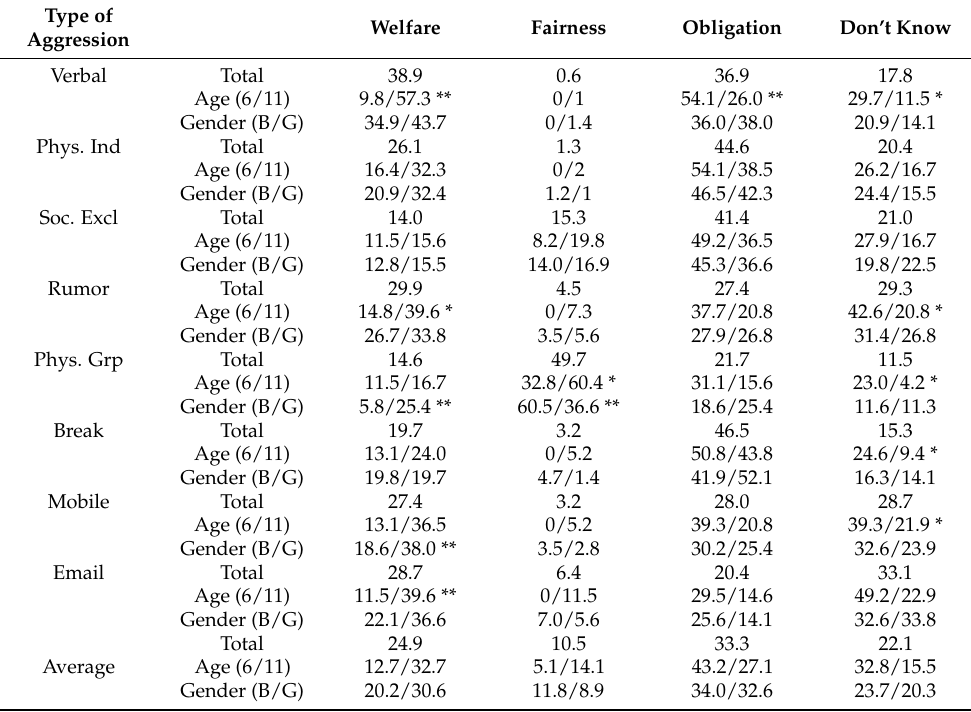
Table 5. Percentage of children giving four categories for reason for judgment, by type of aggression, age, and gender. Type of Welfare Fairness Obligation Don’t Know Aggression Verbal Total